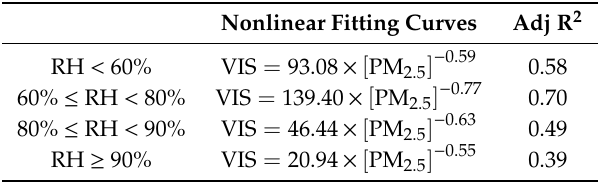
Figure 5. Scatterplot of wintertime visibility and PM 2.5 concentrations in di ff erent RH ranges in Nanjing over 2013–2018 with circles colored in di ff erent RH. The curves and black dots present the fitting curves and their inflection points; black lines of 5 km and 10 km visibility indicate the poor, low, and good visibility levels; and the dashed line represents the light PM 2.5 pollution level of 75 µ g m − 3 . Table 2. Nonlinear fitting equations of visibility and PM 2.5 in di ff erent RH ranges and adjusted coe ffi cients of determination (Adj R 2 ) passing the confidence level of 99%.